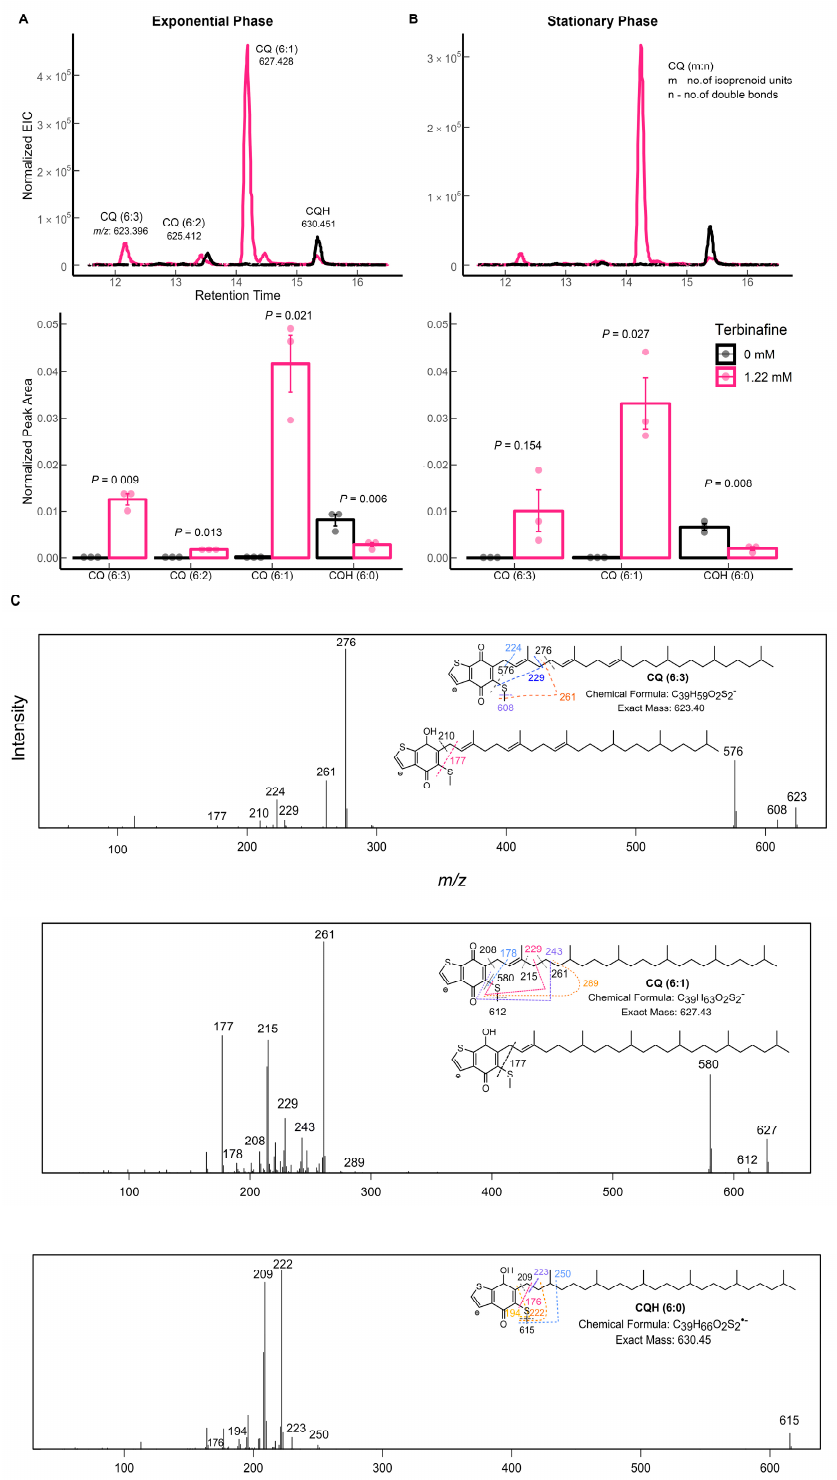
Figure 8. Altered saturation of caldariellaquinone (CQ) under the influence of terbinafine: ( A ) extracted ion chromatogram (top) and relative quantification of peak areas (bottom) in the exponential phase of growth in S. acidocaldarius and ( B ) stationary phase. Error bars represent the standard error of the mean, and p -values are indicated for each lipid species. The dots represent biological replicates. ( C ) Fragmentation patterns of the observed CQ species. The EICs values were normalized to the amount of lipids using the internal standard